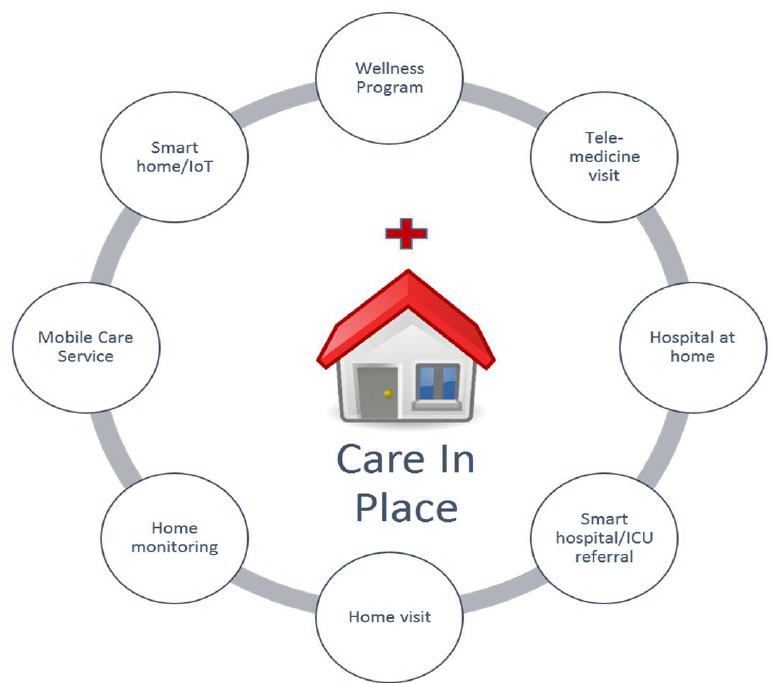
Figure 4. Care in place: Healthcare delivery has traditionally been designed around the provider, located in hospitals, clinics, or doctors’ offices. With advances in telecommunication and telehealth technologies, new solutions have emerged facilitating “care in place” toward settings where the care goes to the patient instead of the patient going to the care.